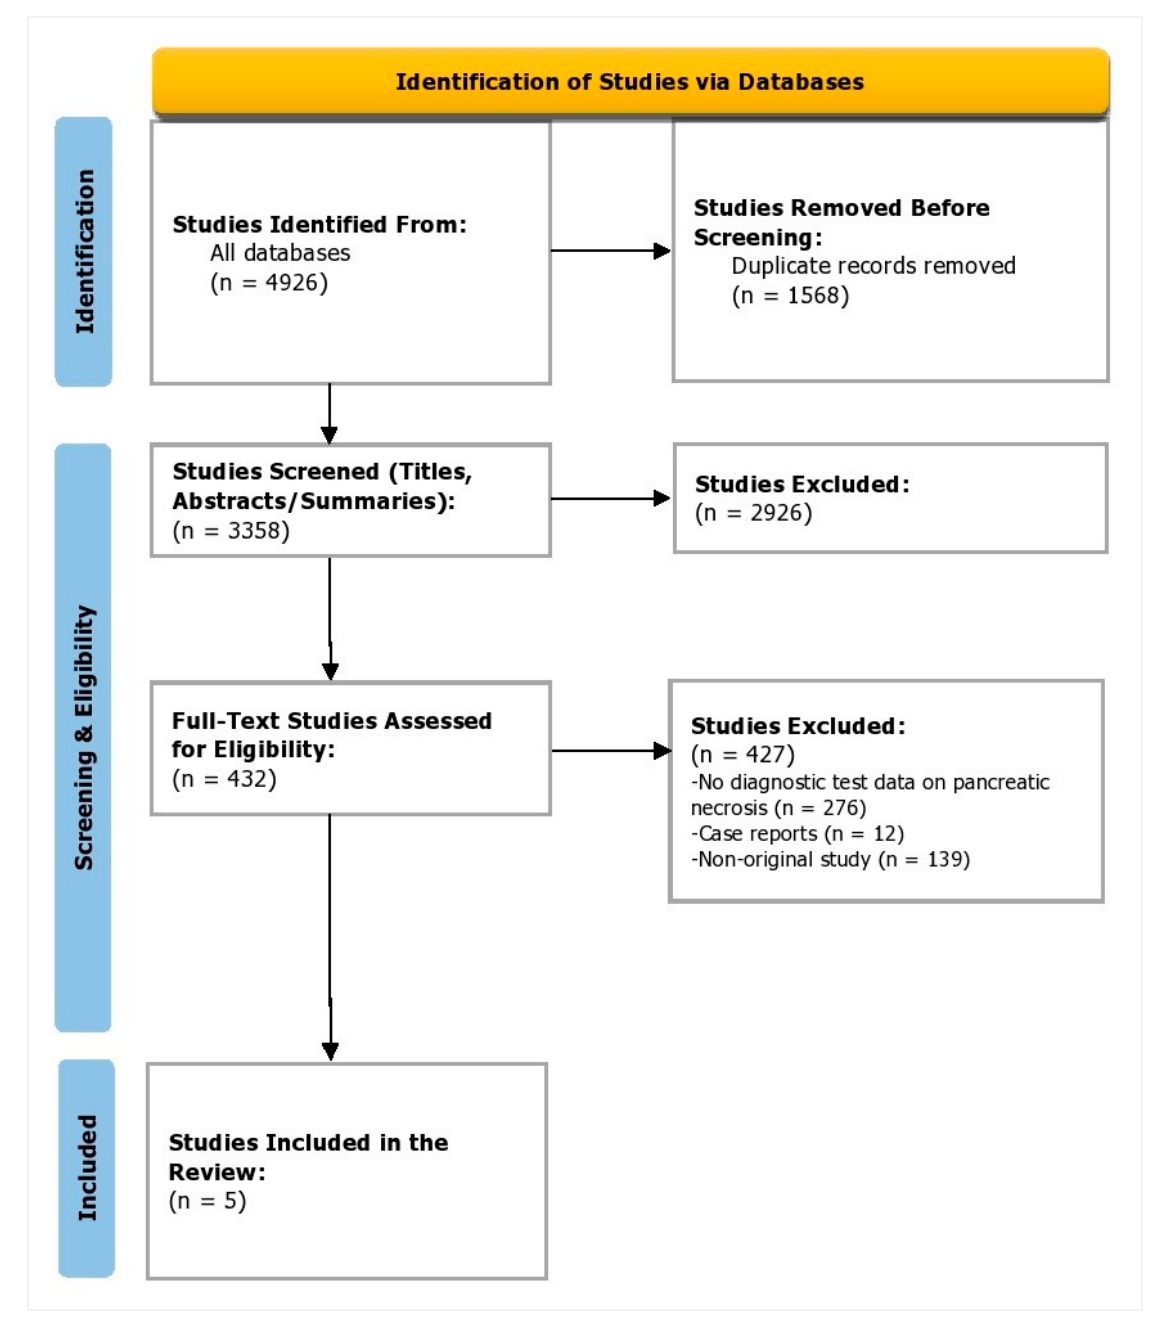
Figure 1. PRISMA flow diagram depicting the study selection process.